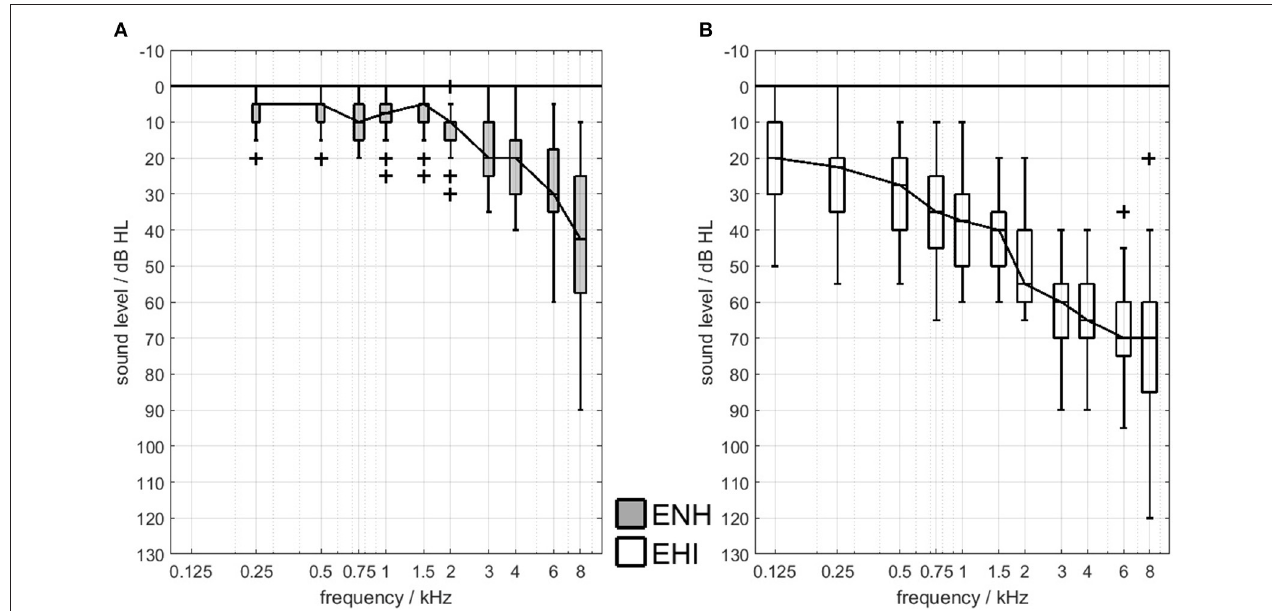
FIGURE 1 | Better-ear hearing thresholds for the ENH group (A) and the EHI group (B) . Lines connect medians and boxes indicate the 25th and 75th percentiles. “ + ” indicates outliers.